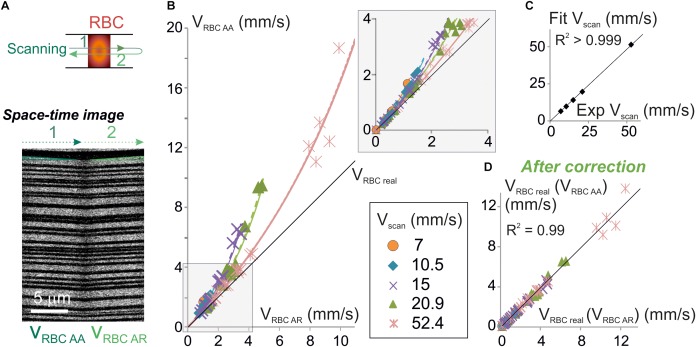
Experimental validation of the algorithm for unbiased measurement of RBC velocity. (A) Apparent velocities of RBCs were simultaneously measured with anterograde and retrograde scanning: each vessel was imaged using a line-scan pattern made of a single segment scanned in both directions (top scheme). Resulting space-time images (bottom picture) gave the anterograde apparent velocity of RBCs (VRBCAA) on their left half (anterograde scanning) and the retrograde apparent velocity of RBCs (VRBCAR) on their right half (retrograde scanning). The beginning and the end of each line was discarded from analysis to avoid periods of scanning acceleration and deceleration. (B) VRBCAA is larger than VRBCAR and their difference increases with Vscan: experimental values of VRBCAA (symbols) versus experimental values of VRBCAR were plot. Each data point is a 2–10 s average value. Data was gathered from 5 to 31 bidirectional line-scans for each Vscan value (see details in Supplementary Figure 1 and see section “Materials and Methods”). Black line = unity line. The relation between VRBCAA and VRBCAR can be fit by Eq. 9: experimental values of VRBCAA versus VRBCAR were fit by Eq. 9: VRBC
AA = | Vscan| VRBC
AR / (| Vscan| - 2 VRBC
AR) (dashed colored lines) and compared to theoretical plots (full colored lines) for a variety of Vscan. Inset: enlargement of the plot initial part. (C) Validation of the physical model to calculate VRBCreal: Vscan values obtained by fitting experimental data in (B) with Eq. 9 were compared to the experimental values of Vscan. Their relationship was well fit by a line of slope 0.98 ± 0.01 (R2 > 0.999), confirming the validity of the theoretical model. (D) Validation of the velocity correction. VRBCreal was computed from experimental values of VRBCAA using Eq. 7a [giving VRBCreal (VRBCAA)] and VRBCAR using Eq. 7b [giving VRBCreal (VRBCAR)]. The relation between VRBCreal (VRBCAA) and VRBCreal (VRBCAR) can be fit by a line of slope 1.00 ± 0.02 (R2 = 0.99), showing that both methods give the same values for VRBCreal as predicted by our model.